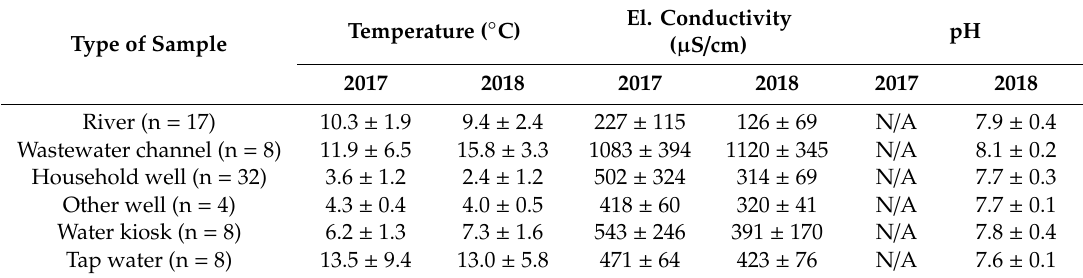
Table 2. General physico-chemical characteristics according to sample type (mean values).